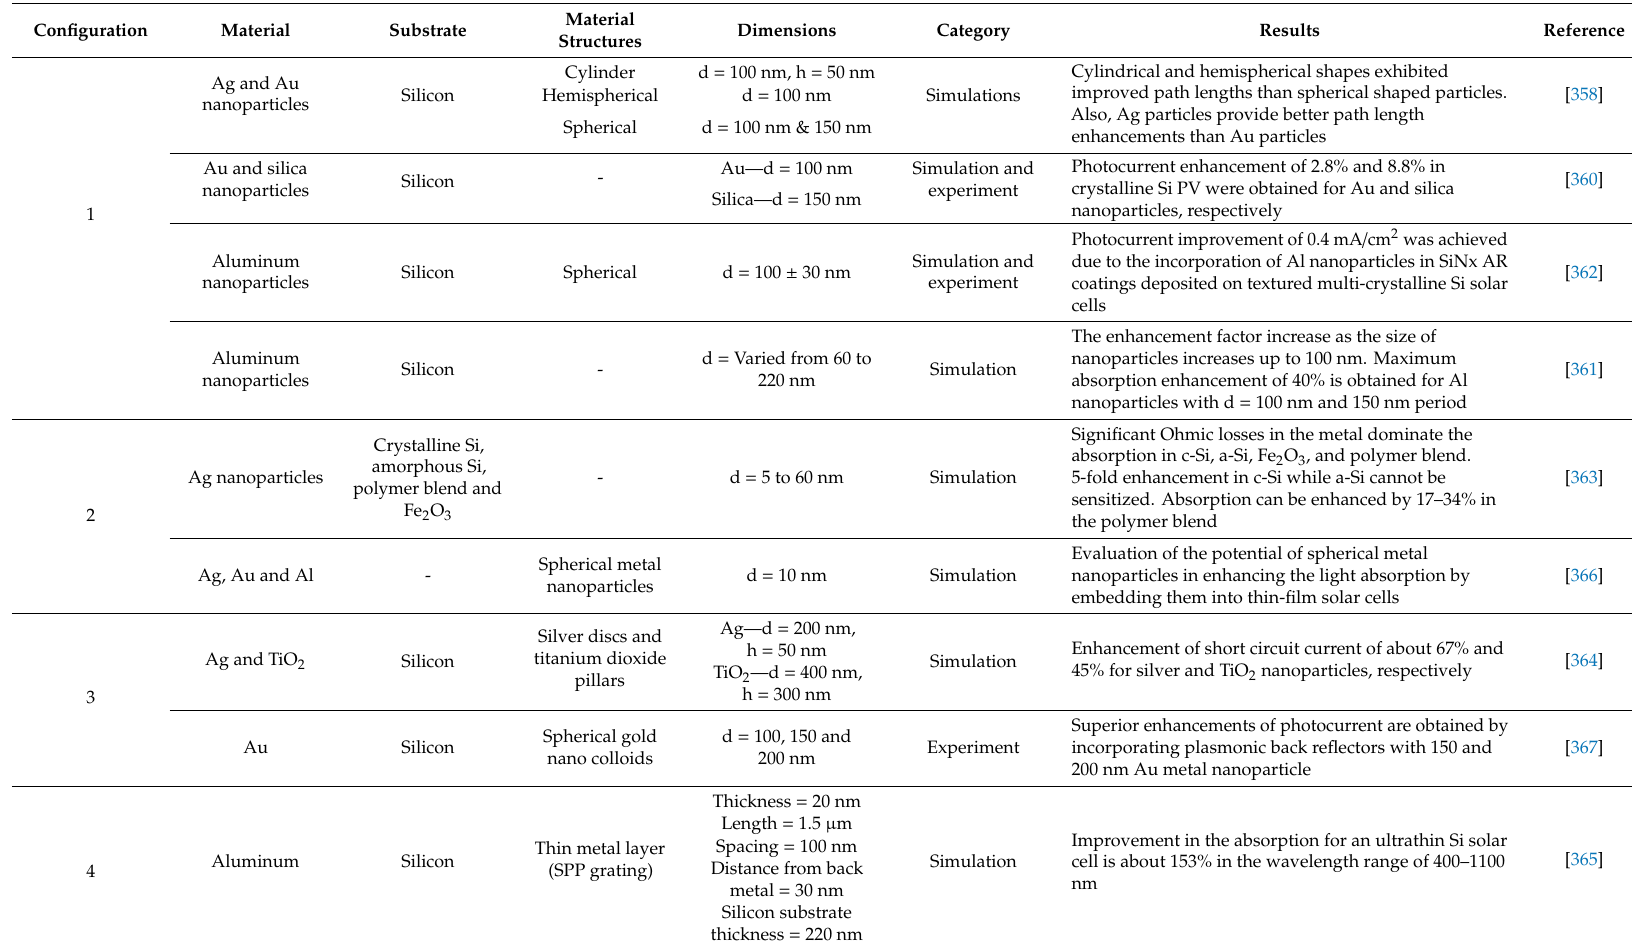
Table 8. Various plasmonic enhanced solar cells with di ff erent light trapping